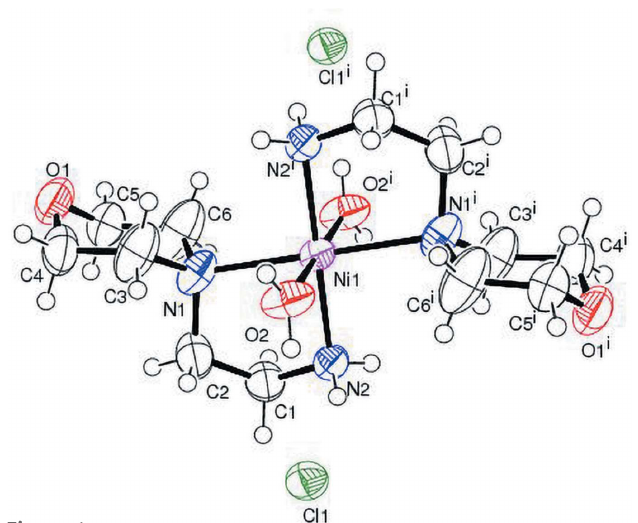
Figure 1 ORTEP diagram of the title compound with the atom-numbering scheme. Ellipsoids are drawn at 50% probability. Only the main component of the disordered ligand is shown for clarity. [Symmetry code: (i) (cid:4) x + 1, (cid:4) y + 1, (cid:4) z + 1.]